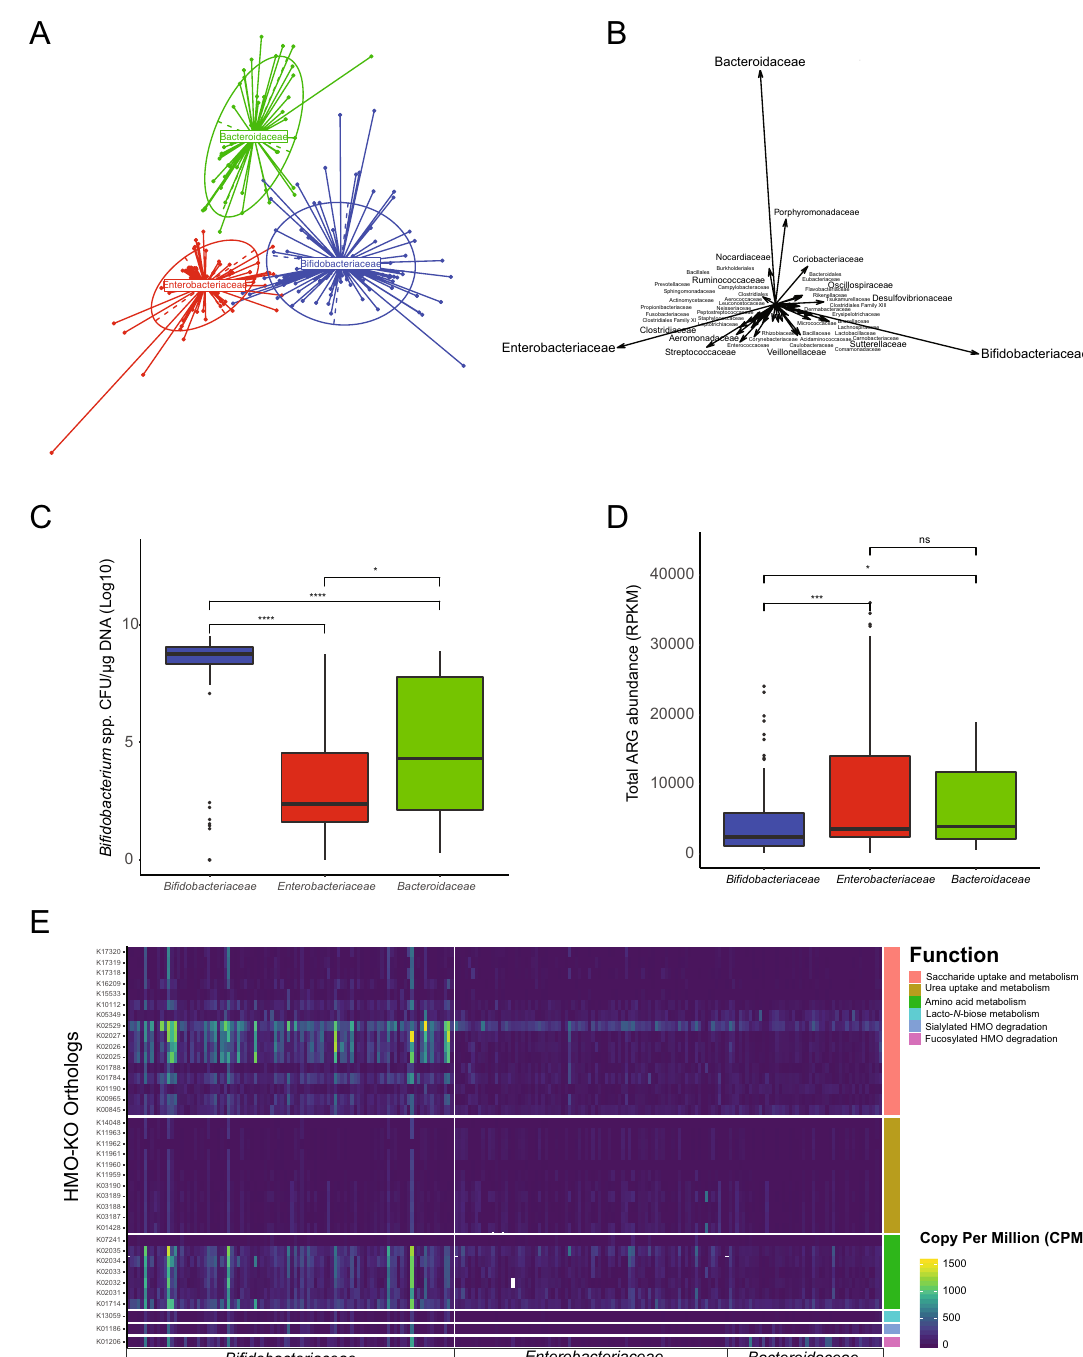
Figure 5. Enterotype grouping, Bifidobacterium abundance and functional gene annotation. ( A ) Enterotype analysis of samples at the family level. Samples clustered in three different enterotypes reported by different colors. In the center of the cluster is shown the main bacterial family responsible for the enterotype formation. ( B ) Bacterial families driving enterotype formation. Longer arrows indicate a stronger contribution. ( C ) Quantification of total Bifidobacterium spp. by enterotype. ( D ) Abundance of ARGs in all samples grouped by enterotype. ( E ) Heatmap showing relative abundance and functional annotation of KEGG orthologous genes related to HMO-utilization across